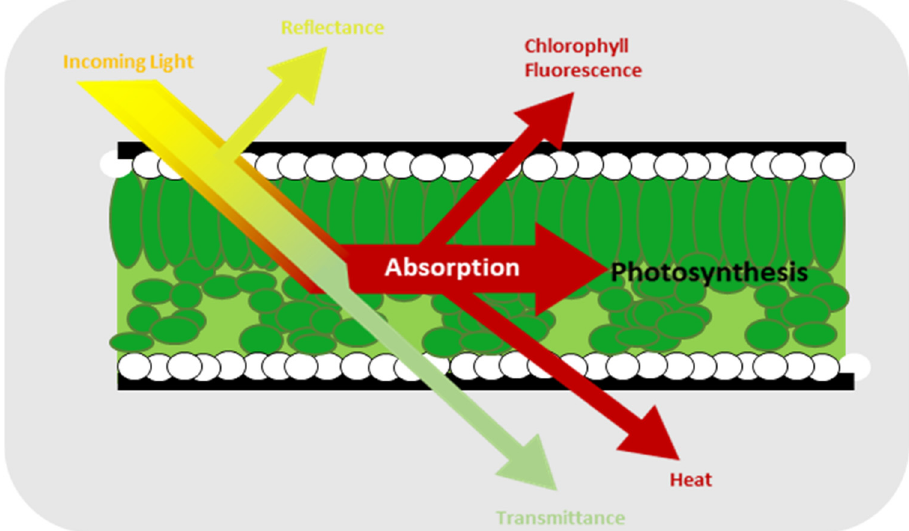
Figure 1. Events caused by light hitting the leaves of a plant [16].